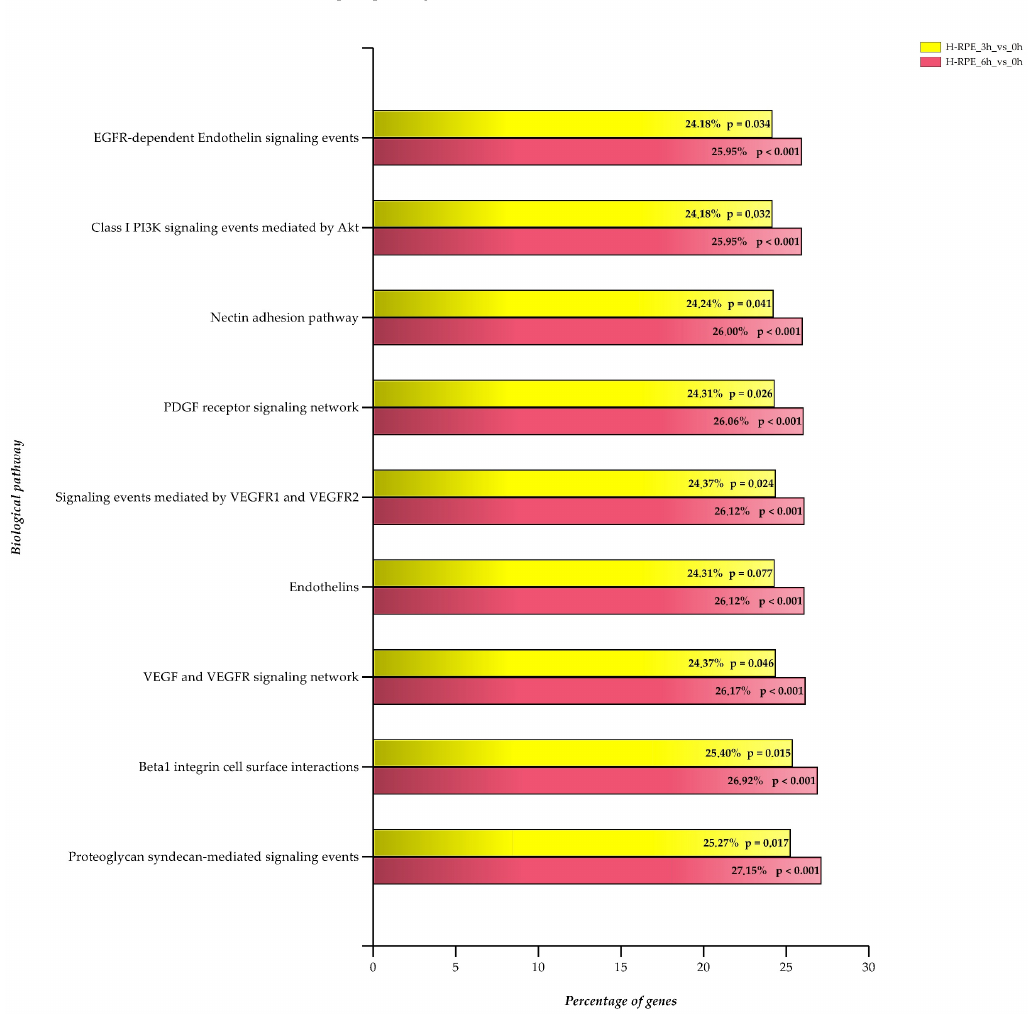
Figure 5. Enriched genes in biological pathways related to angiogenesis. Each biological pathway is considered both 3 and 6 h after A2E treatment. Enrichment percentage and the Bonferroni-adjusted p -value are